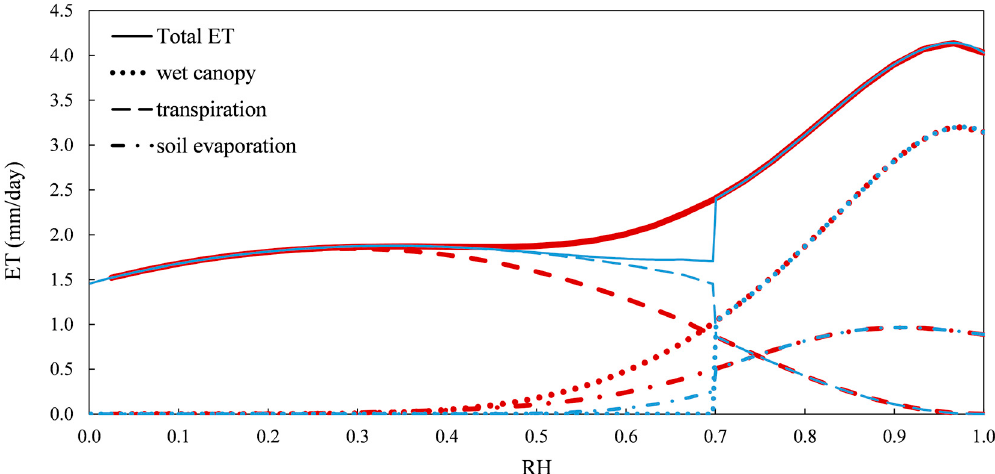
Figure 1. Variations in total and individual ET components as a function of relative humidity for select conditions (minimum and maximum temperatures of 15 °C and 30 °C, LAI of 4, albedo of 0.19, sea level elevation, 30 degrees latitude, EBF land cover type and time of year is mid-July): MODIS ET wet fraction method (Blue color), and wet fraction determined using Equation (9) with an β of 4 and RH min of 0 (Red color).